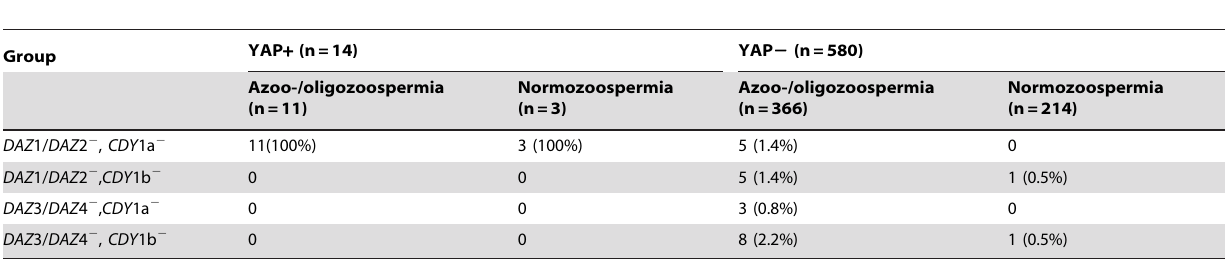
Compared between the groups with azoo-/oligozoospermia and normozoospermia, no significant difference by fisher’s exact test (two-tailed), P . 0.05.